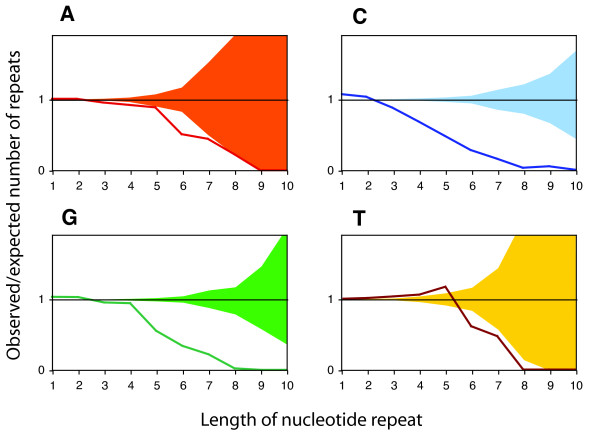
Proteins of M. tuberculosis are encoded in a way that minimizes the emergence of mononucleotide repeats. The lines depict the ratio between the observed and expected number of mononucleotide repeats (summed over all genes in the genome) as a function of their length. The expected numbers were calculated with a null-model that conserved the amino acid sequence and the gene-specific codon frequencies. The areas comprise 95% of the data from the randomized genomes. For repeats of three (for A, C and G) or six (for T) nucleotides and longer, the lines lie below this area, indicating that such repeats are significantly under-represented.